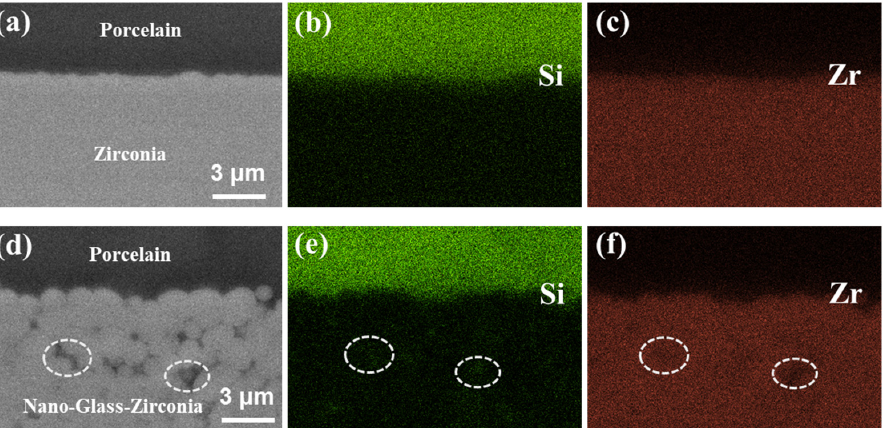
Figure 8. The BSE images and EDS mapping at the interface region. The BSE images of sZirL ( a ) and ngZirL ( d ). The EDS mapping of Si ( b ) and Zr ( c ) at the interface of sZirL. The EDS mapping of Si ( e ) and Zr ( f ) at the interface of ngZirL.